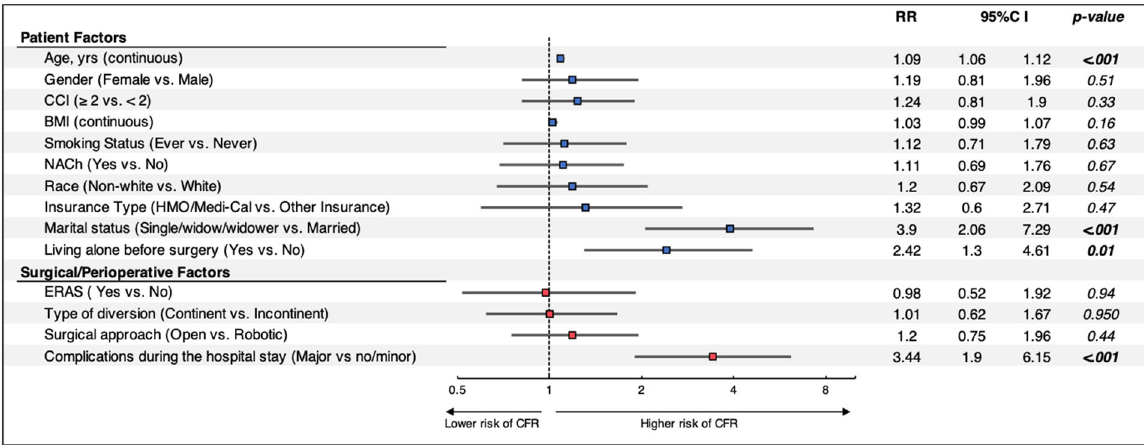
Figure 2. Multivariable regression models assessing the impact of patient, surgical, and periopera ‐ tive factors on discharge disposition after RC. Patients without ERAS information were excluded from further analysis. RR: Risk Ratio; CI: Confidence Interval; CCI: Charlson Comorbidity Index; BMI: body mass index; LOS: length of stay; NACh: Neoadjuvant Chemotherapy; ERAS: Enhanced Recovery After